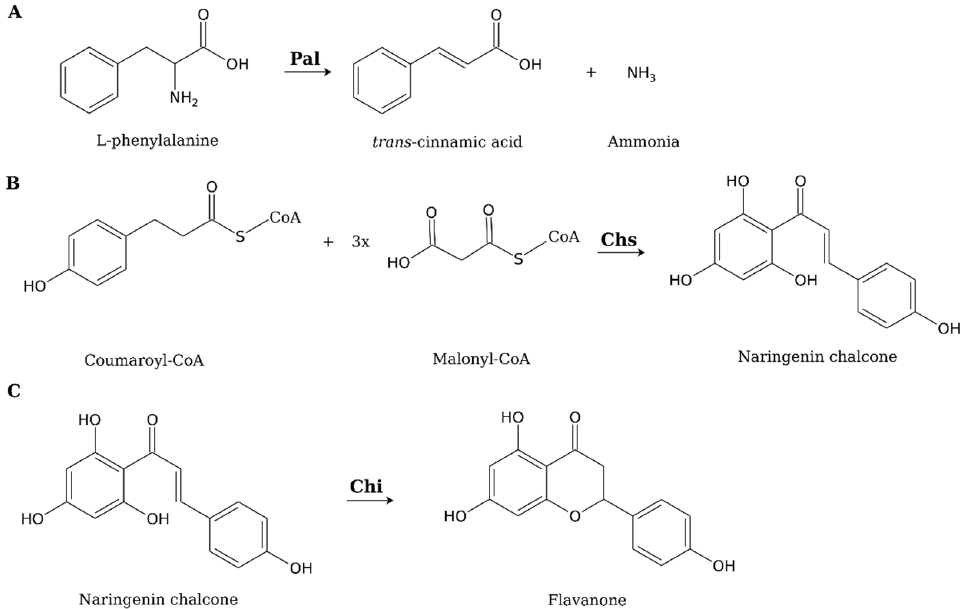
Figure 1. Reactions catalyzed by: phenylalanine ammonia-lyase (Pal)-( A ), chalcone synthase (Chs)-( B ) and chalcone isomerase (Chi)-( C ). Based on [66] and modified.